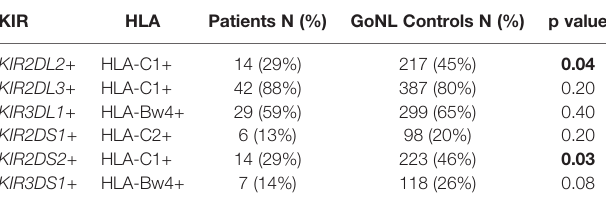
TABLE 3 | KIR receptor – HLA ligand interactions in EBV+ NS cHL patients and GoNL controls.